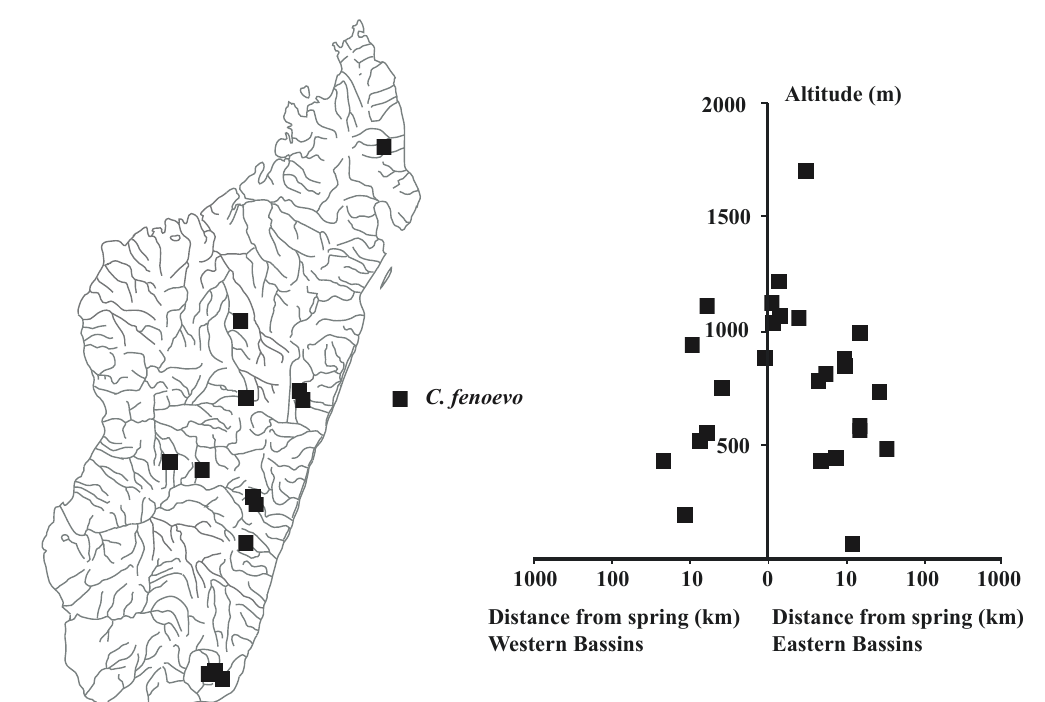
Fig. 15. Chimarra fenoevo sp. nov., schematic distribution map and ecological profile of the capture sites in Madagascar.